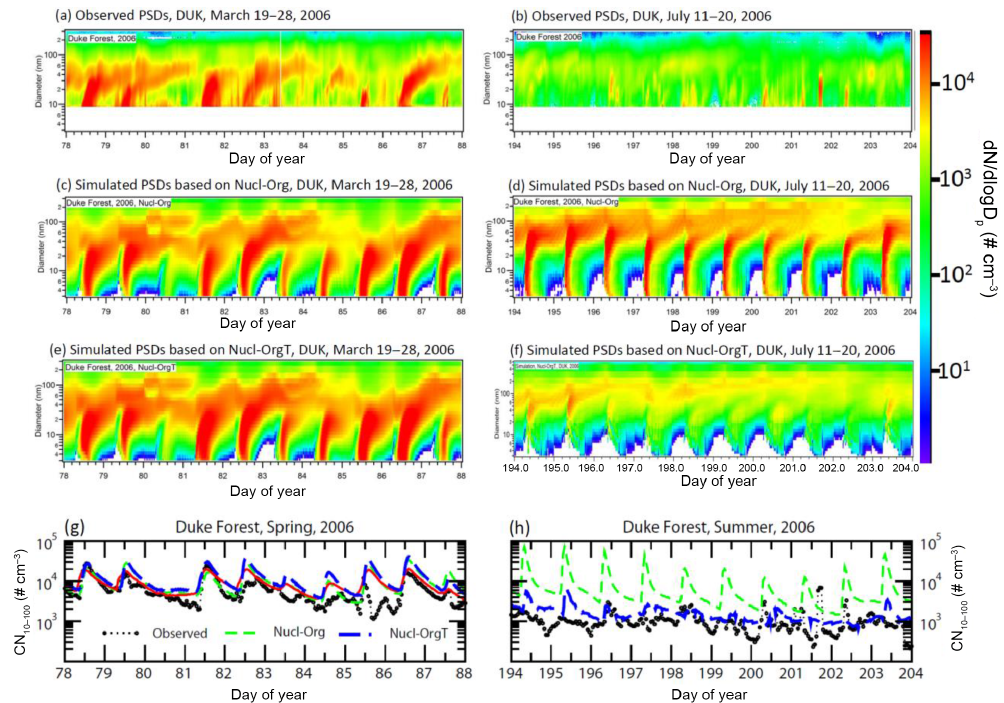
Figure 7. The particle size distributions (PSDs) observed (a, b) and simulated based on the Nucl-Org (c, d) and Nucl-OrgT (e, f) schemes during two 10-day periods in March (a, c, e) and July (b, d, f) 2006 in Duke Forest (DUK), along with a time series of the concentration of condensation nuclei between 10 and 100nm (CN 10–100 ) (g, h) .